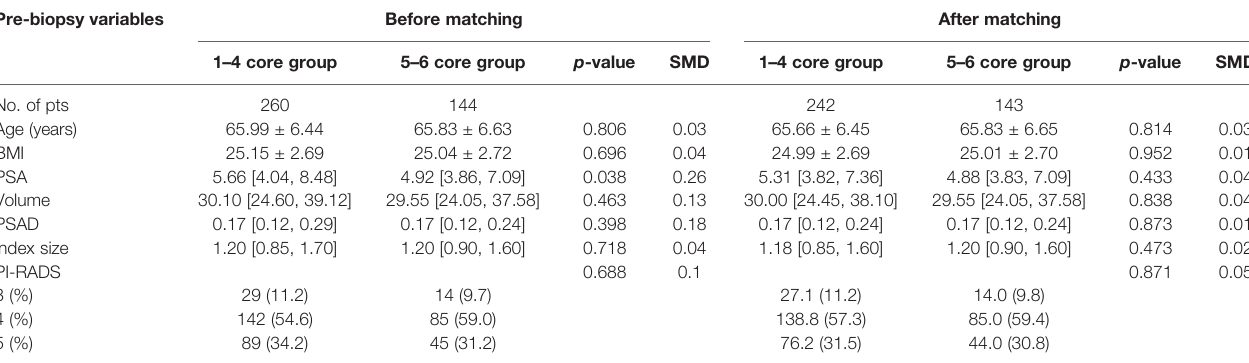
TABLE 2 | Baseline characteristics before and after propensity score matching. Pre-biopsy variables